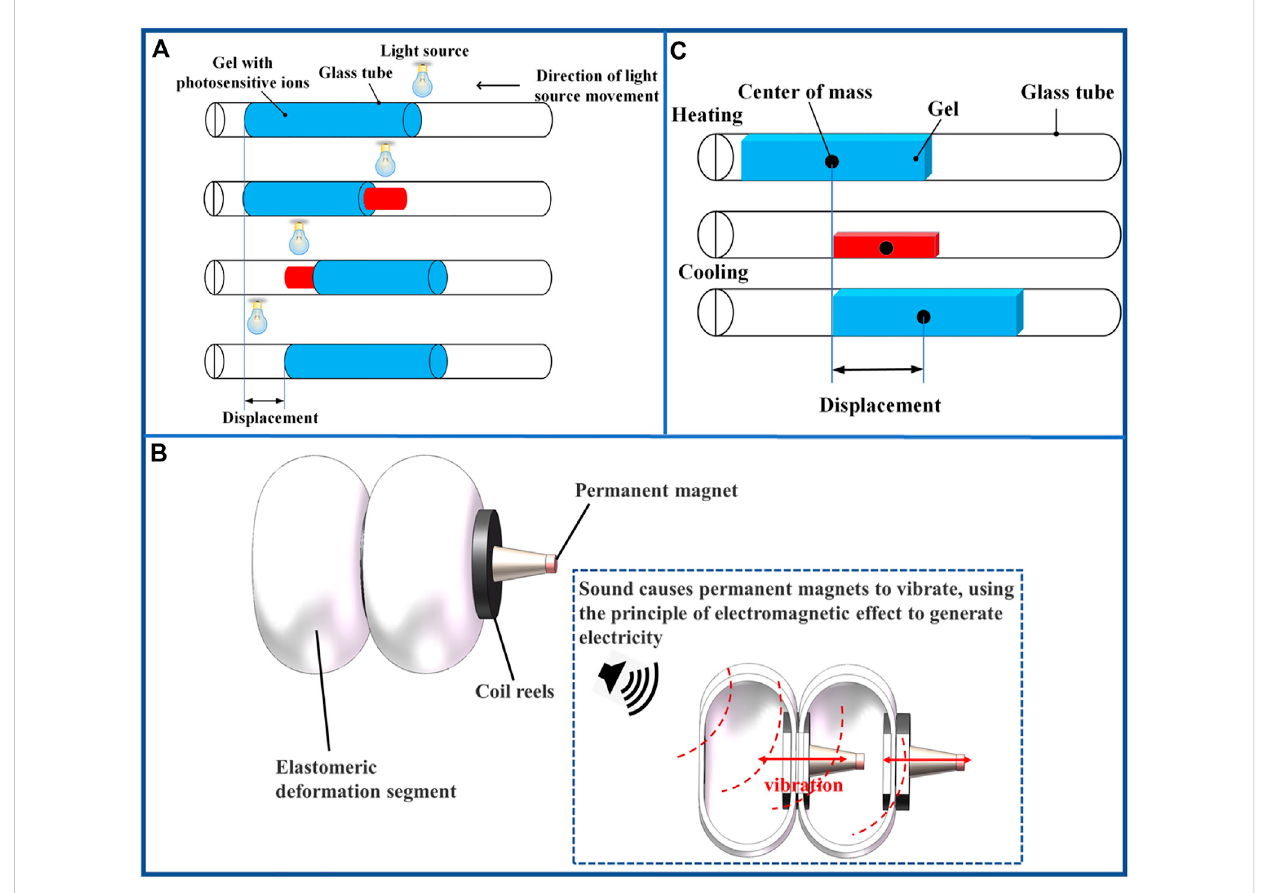
FIGURE 17 Examples of multi-segment earthworm-inspired soft robots using emerging actuation methods. (A) Motion of optical-driven earthworm-inspired robot. (B) Connection diagram and principle of common sound-driven earthworm-inspired robot. (C) Motion process and structure of thermal-driven